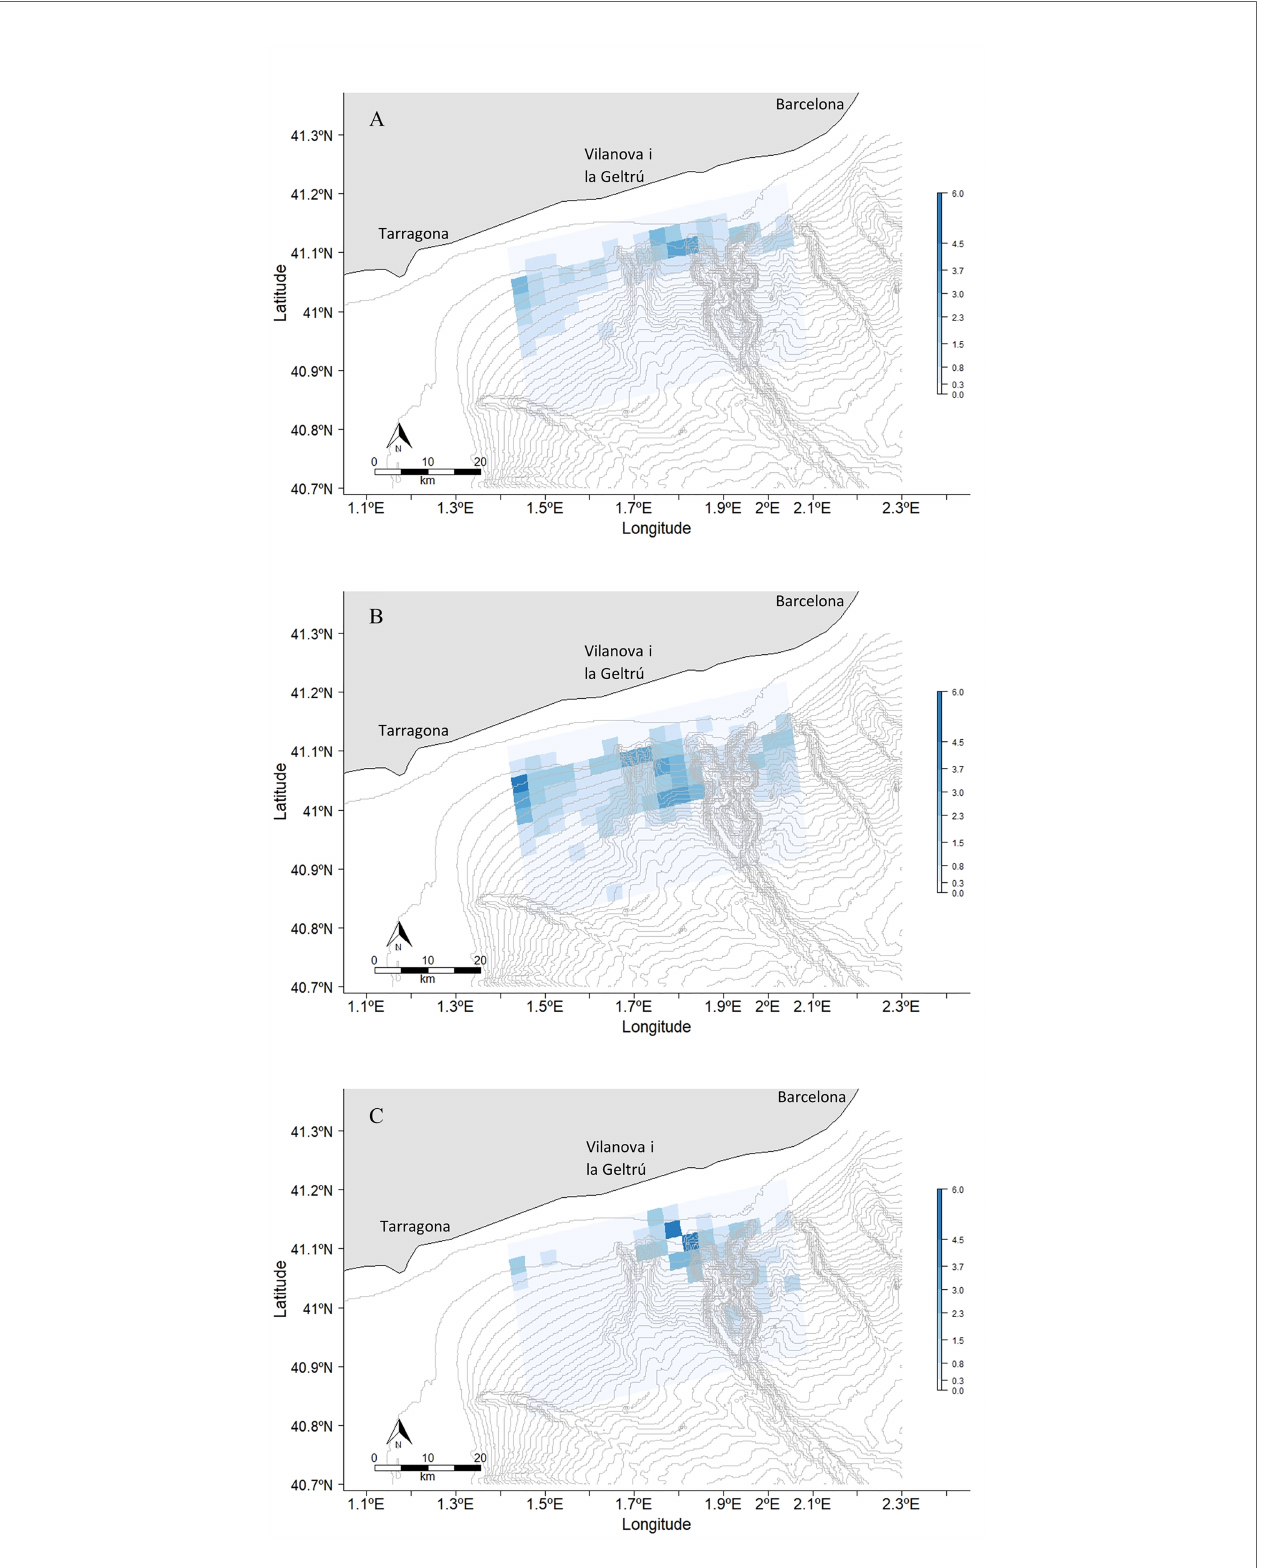
FIGURE 3 | Fin whale distribution in (A) March, (B) April and (C) May 2021 within the study area. The bathymetric lines are drawn every 50 m depth. The Number of animals sighted per pixel varied between